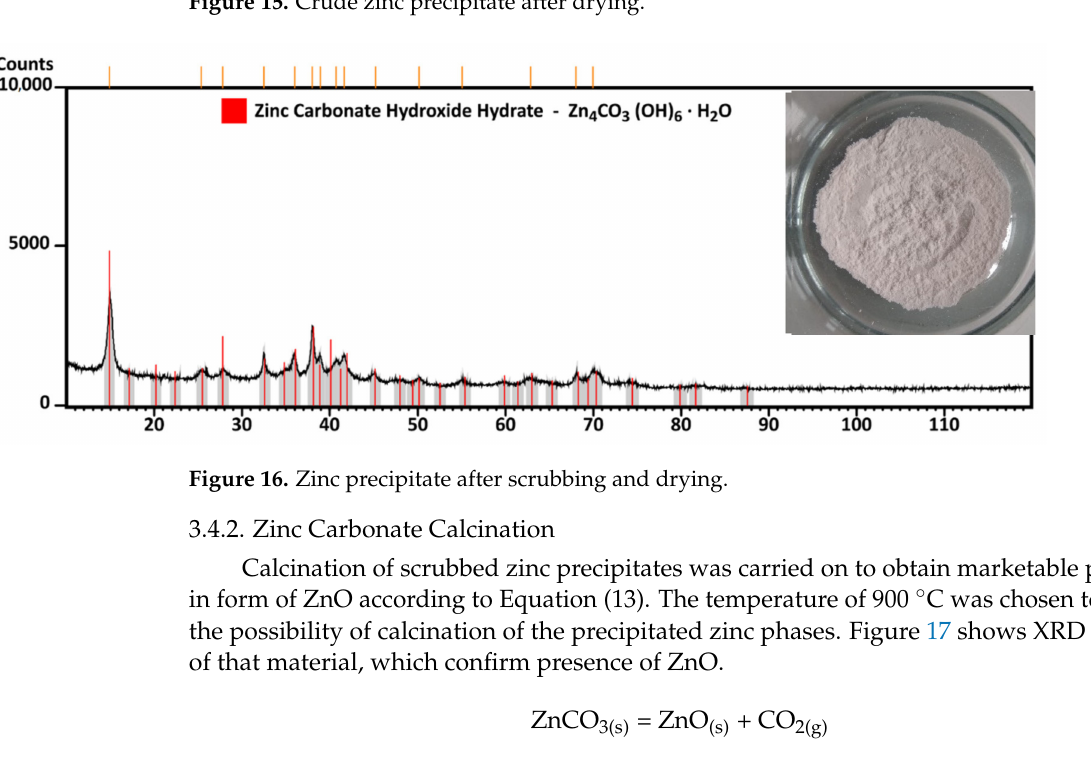
Figure 15. Crude zinc precipitate after drying.